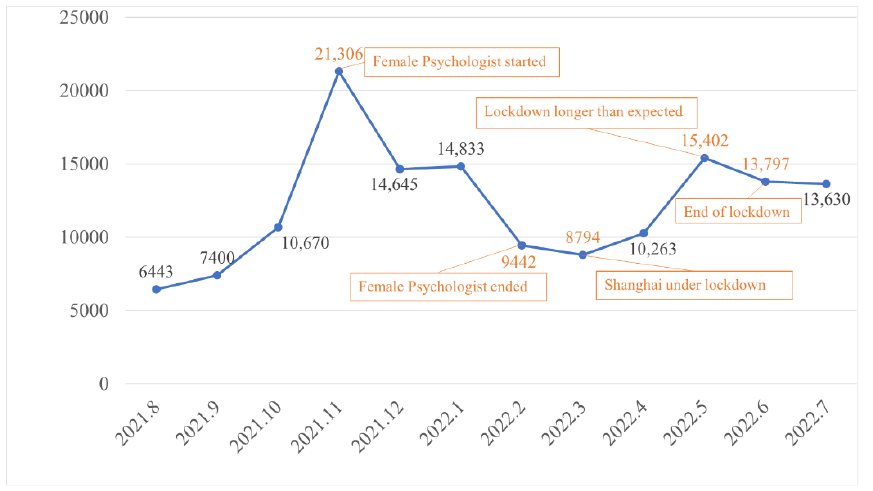
Figure 3. Total number of Weibo posts for 12 months from August 2021 to June 2022.